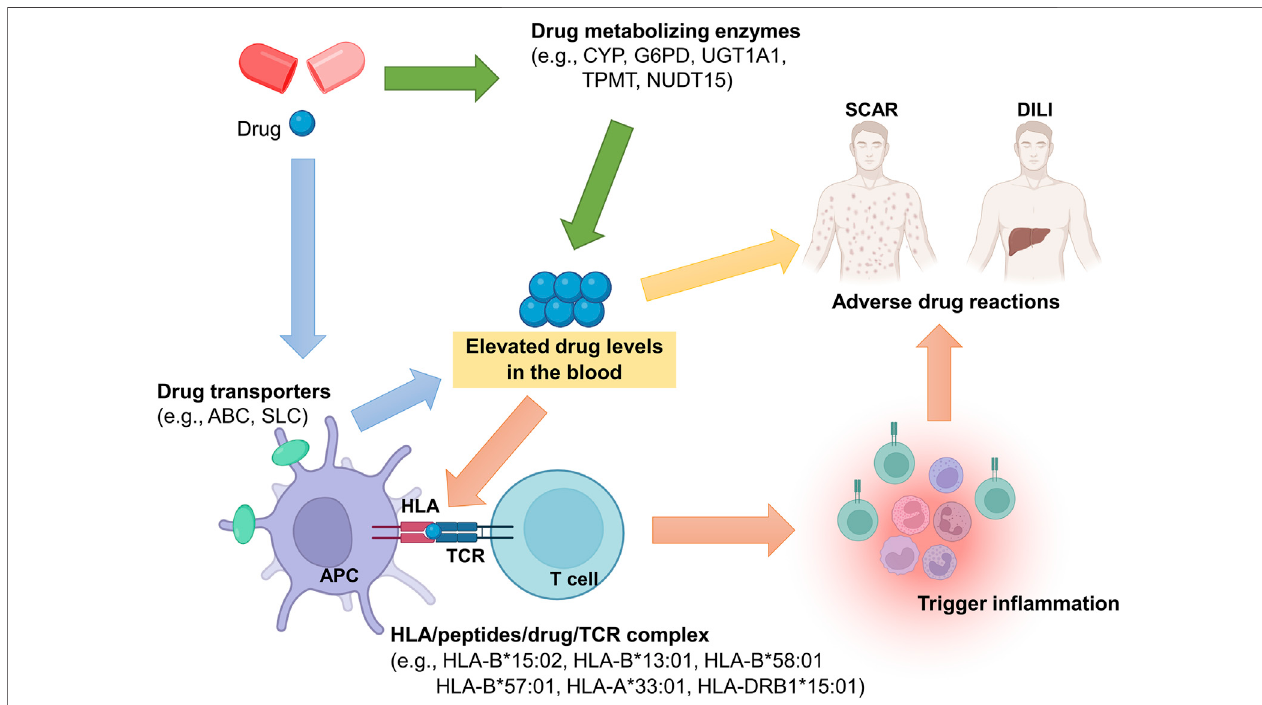
FIGURE 1 | Potential genetic determinants involved in pathogenesis of severe ADR. Genetic polymorphisms in drug metabolizing enzymes or drug transporters may alter their function, and then elevated drug levels in the blood, resulting in ADR occurrence. Also, the drug may trigger immune responses through HLA/drug/TCR complex. In the HLA/drug/TCR model, HLA is considered as the key molecular for induction of ADR. Taken together, genetic polymorphisms ofHLA, drug metabolizing enzyme, drug transporter, and TCR play important roles in ADR pathogenesis.